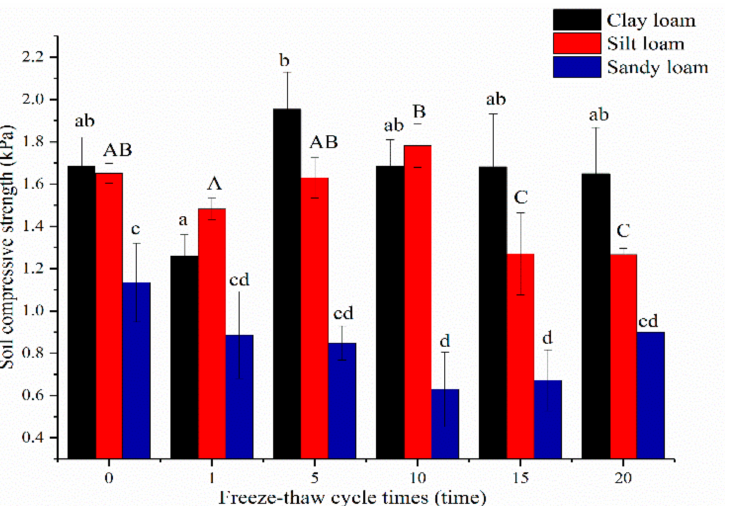
Figure 7. Relationship between soil compressive strength and freeze-thaw cycles of three soils. Note: The letters indicated whether the differences in the test results were significant or not. “a, b” stands for clay loam, “A, B, C” stands for silt loam, “c, d” stands for sandy loam. Different letters indicate a significant difference of test results among the different freeze-thaw cycles and soils at the 0.05 level.